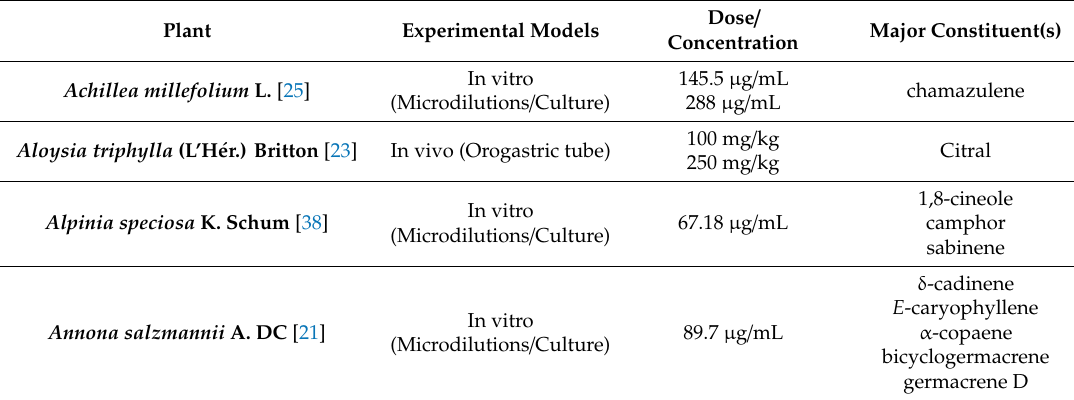
Table 1. Essential oils with trypanocidal activity against T.